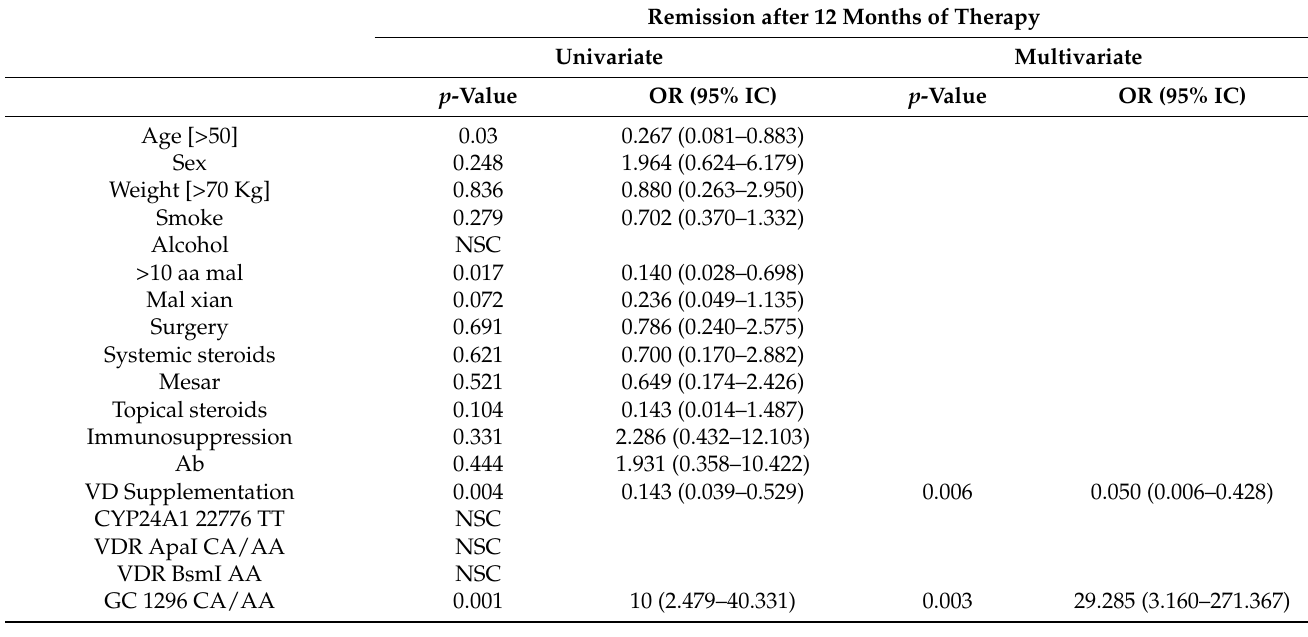
Table 4. Logistic regression analysis at twelve months of therapy. NSC: Not statistically comparable, as one group is missing; OR: Odds ratio , 95% IC: Interval of confidence at 95%.